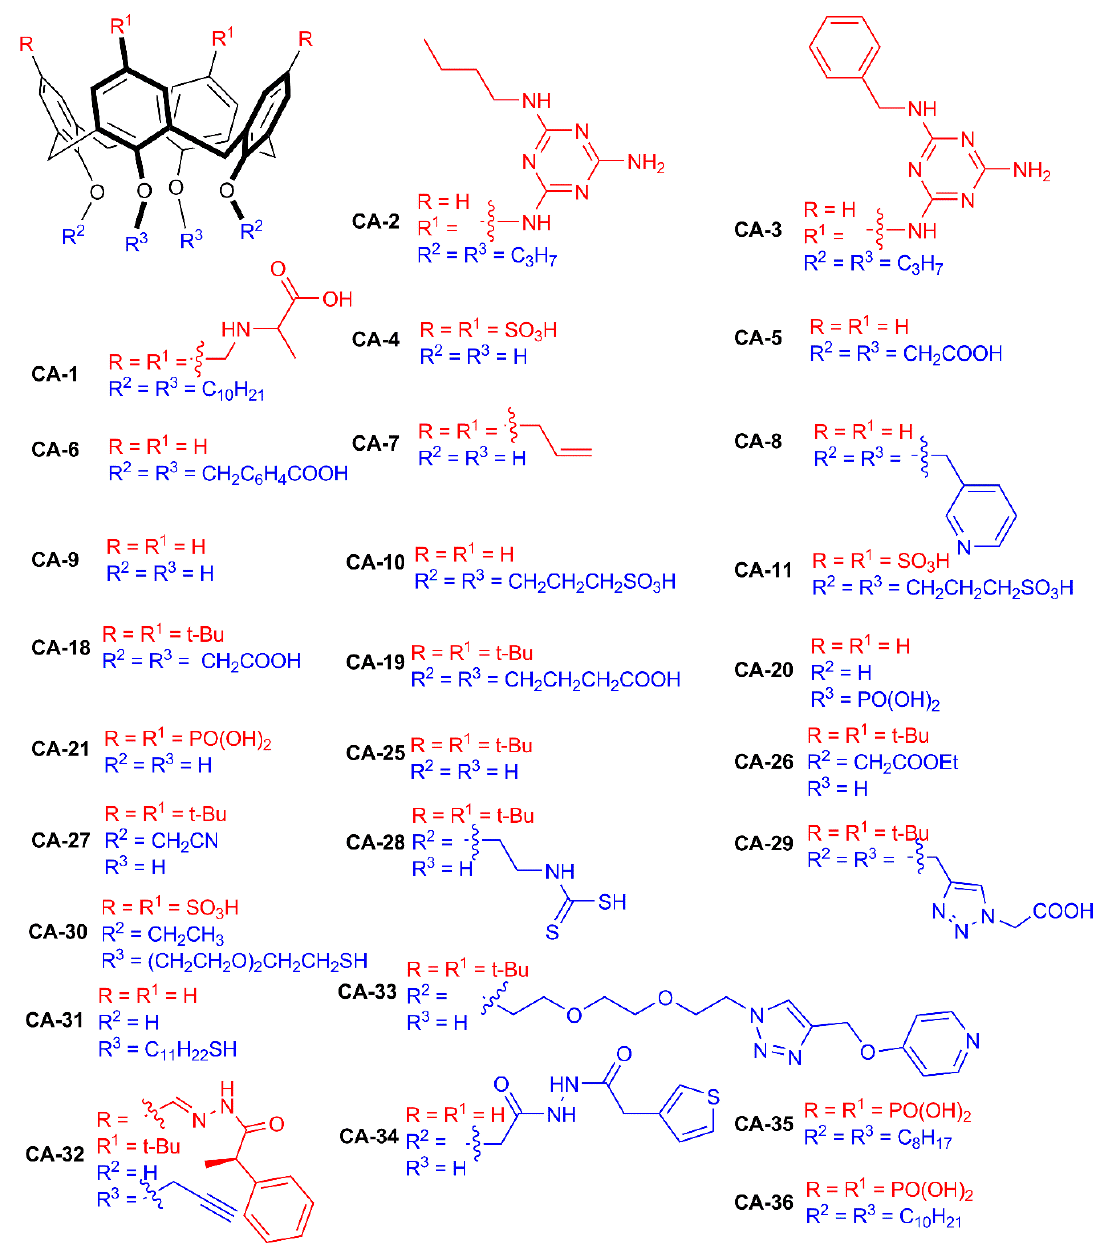
Figure 3. Structures of